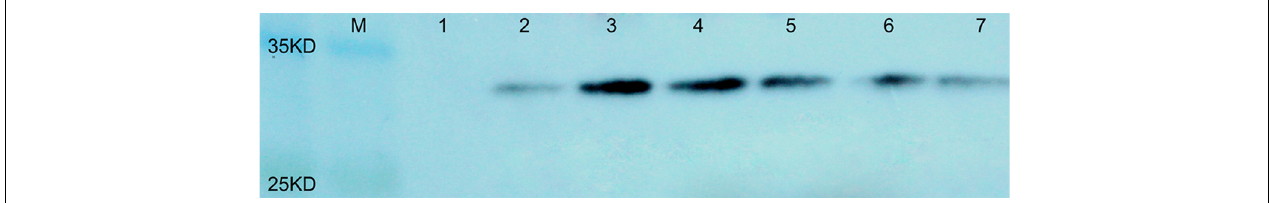
FIGURE 4 | Western blotting of the AtLEC1–MYC fusion protein in seeds of different transgenic peanut lines. M, prestained protein ladder (180, 135, 100, 75, 63, 48, 35, 25, 17, and 11 kDa; Thermo Scientific); 1, untransformed control; 2–7, different transgenic peanut lines (040305-6-5, 040201-11-8, 040603-3-9, 030801-3-5, 031001-2-3, and 031607-2-4, respectively).